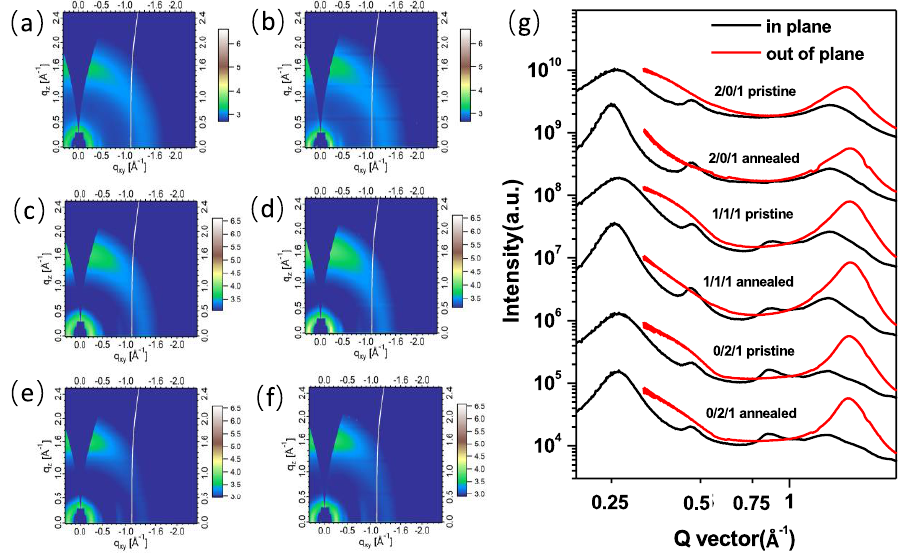
Figure 6. ( a ) GIWAXS 2D patterns of TQ1 / PCE10 / PNDI-T10 blend films without ( a , c , e ) and with ( b , d , f ) thermal annealing for di ff erent blend ratio: ( a , b ) 2 / 0 / 1, ( c , d )1 / 1 / 1, and ( e , f ) 0 / 2 / 1; ( g ) scattering profiles of in-plane and out-of-plane of di ff erent blend films with and without thermal annealing.